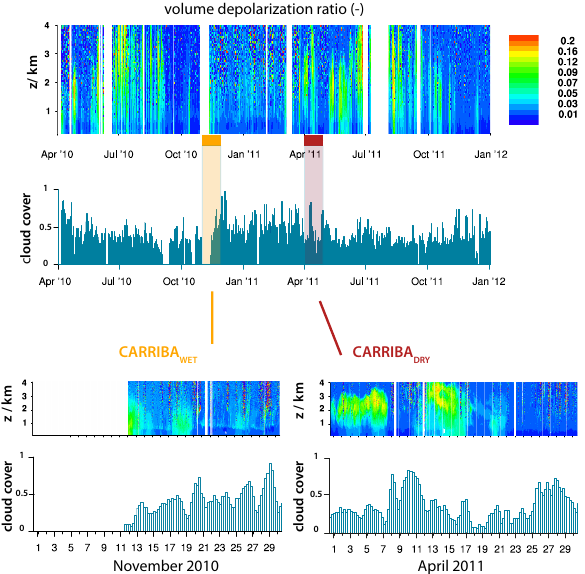
Fig. 4. Time series of volume depolarization ratio measured by the Raman lidar and ceilometer-derived low level cloud cover (frac- tion of time with a cloud base height < 5km) both measured at BCO. Below are zoom ins on the two CARRIBA periods in Novem- ber 2010 and April 2011. The long data gap at the beginning of CARRIBA WET was due to a power outage related to the hurricane Tomas that passed over Barbados.